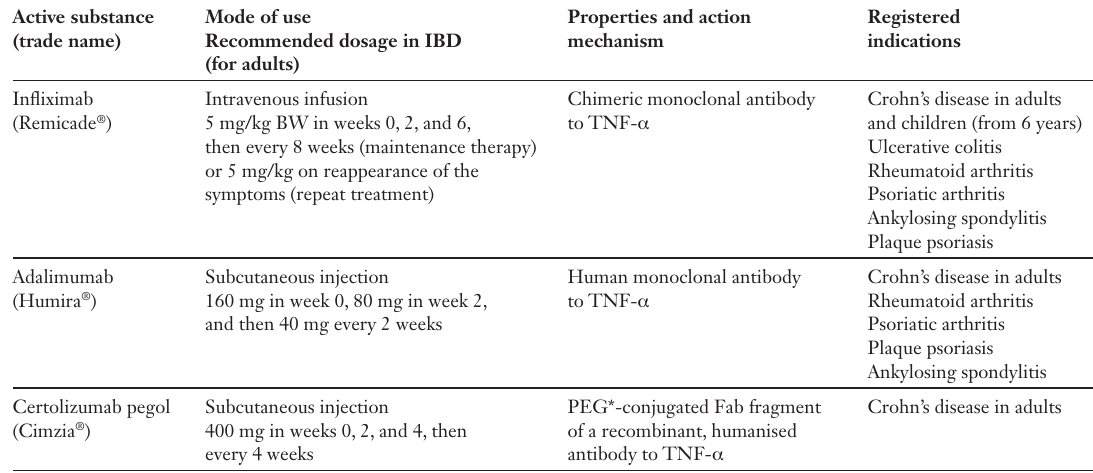
Overview of the TNF- α antagonists registered for the treatment of Crohn’s disease in Switzer- land.